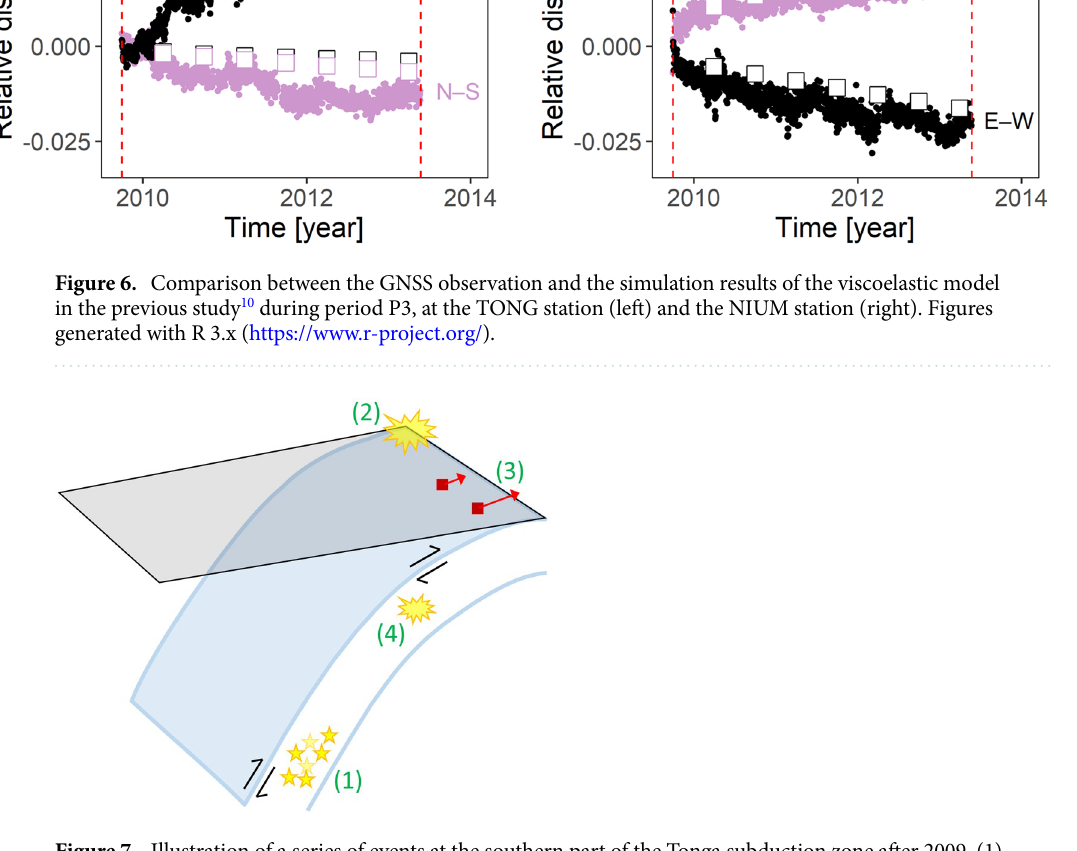
Figure 7. Illustration of a series of events at the southern part of the Tonga subduction zone after 2009. (1) Beginning of the quiescence of the deeper earthquakes. (2) The 2009 M8.1 shallow earthquake in the far north. (3) Beginning of the trenchward displacements at the upper plate TONG and VAVS stations (red arrows). (4) The 2013 M7.4 intraslab earthquake, and the end of the above “slow deformation